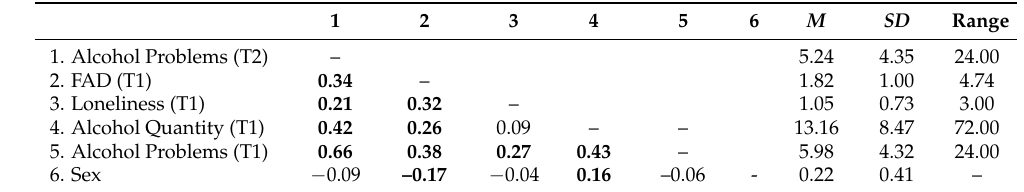
Table 2. Bivariate correlations and descriptive statistics among study